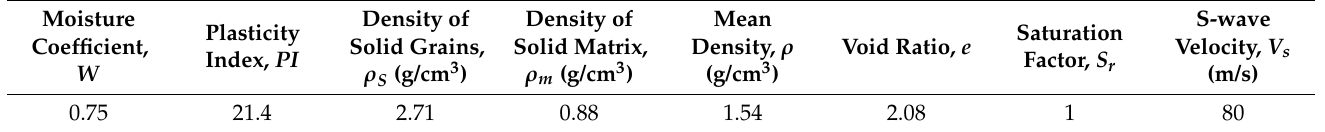
Figure 4. Ocean-bottom seismometers (OBS) deployments at the Black Sea shelf sites: 1 —on the surface of the soft clay layer of 14 m; 2 —on the surface of the soft clay layer of 5.5 m; 3 —on the hard flysch outcrop. Table 1. Geotechnical parameters of the soft clay at the sites on the shelf near the Anapa city.